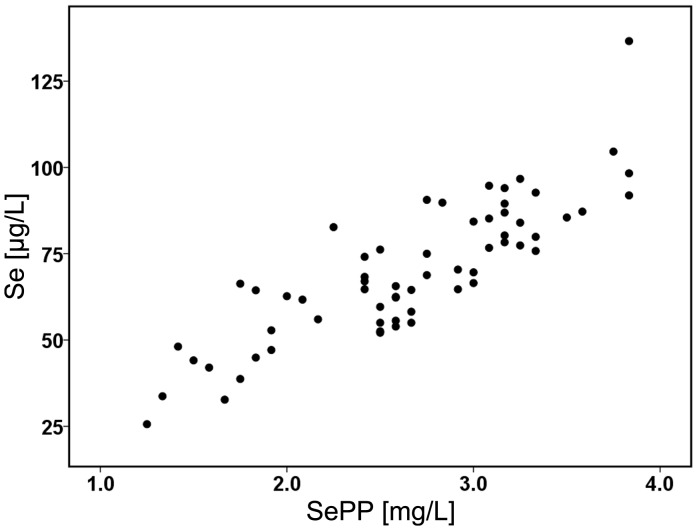
Dotplot analysis of Se and SePP concentrations.Serum Se concentrations were determined by total reflection X-ray fluorescence and serum SePP concentrations were determined by an immunoluminometric sandwich assay. Both markers of Se status correlate linearly as known from Se-deficient individuals (Pearson’s correlation coefficient = 0.849; p<0.001).